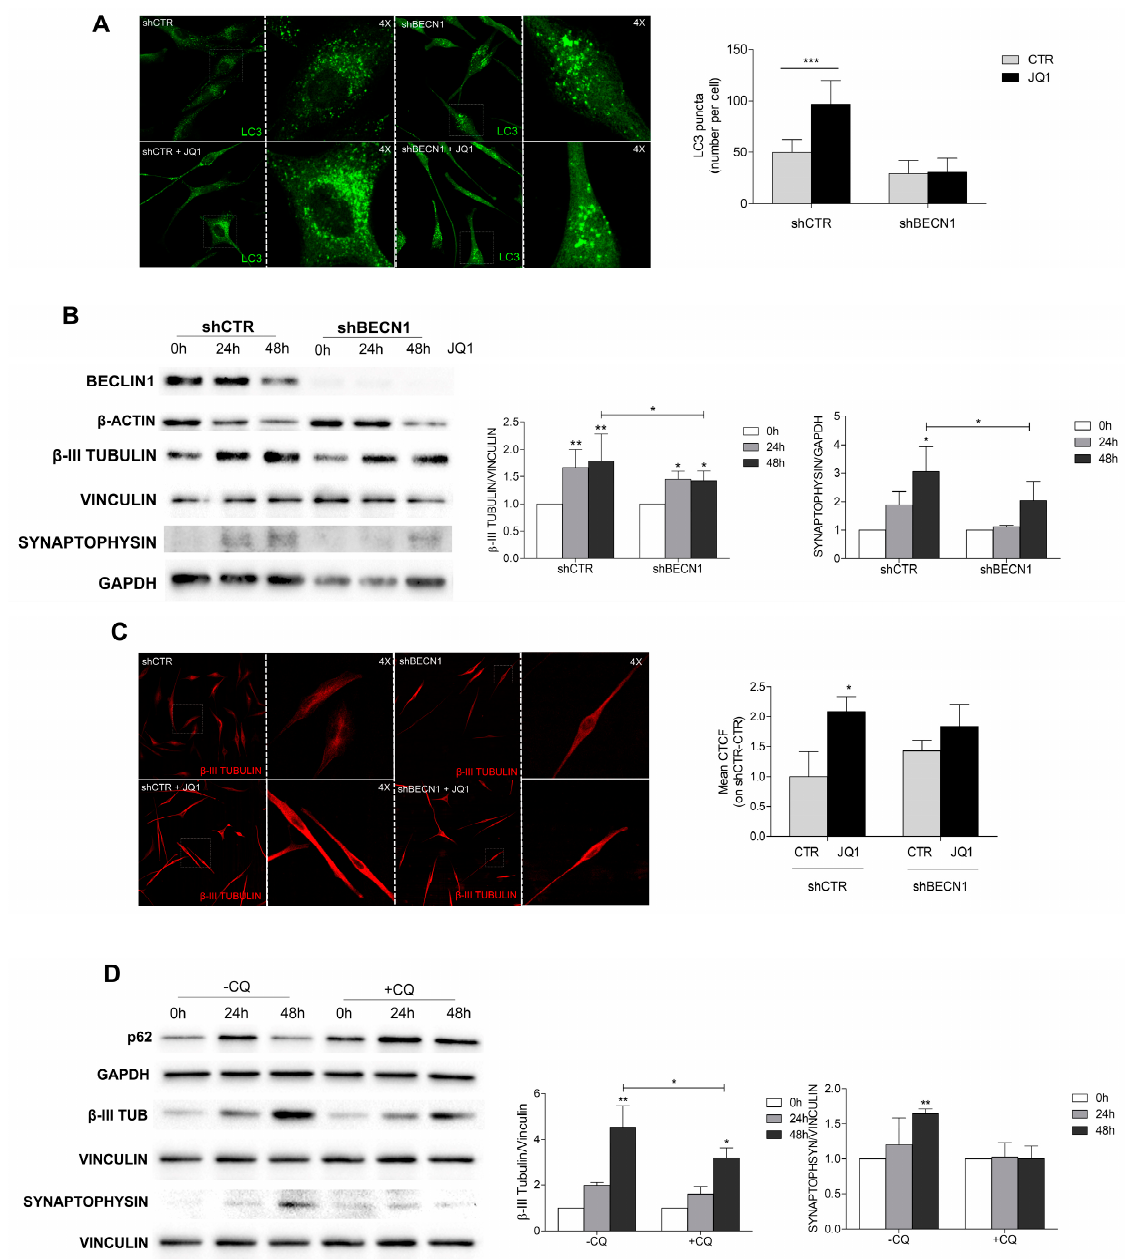
Figure 6. Autophagy-defective cells are less likely to differentiate than autophagy-proficient ones. (A) GL15 cells silenced for the BECN1 gene (shBECN1) or for a scramble gene (shCTR) were cultured in DMEM (CTR) or in the presence of 0.5 µ M of JQ1 for 48 h and subjected to immunocytochemistry and confocal analysis for LC3 (green). Representative images of at least 10 fields showing the merged signals are shown. Scale bar: 30 µ M. A 4 × magnification is shown in the right panel. The LC3 puncta per cell were counted in 30 cells for each condition and the corresponding graph is shown. Statistical significance: ** p < 0.01 and *** p ≤ 0.001, Student’s t -test. ( B ) Western blot analysis of β 3-TUBULIN and SYNAPTOPHISIN was performed in shBECN1 and shCTR GL15 cells cultured in the presence of 0.5 µ M of JQ1 or in DMEM medium (CTR) for 24 and 48 h. A specific antibody for BECLIN1 was used to confirm the silencing efficiency. GAPDH, VINCULIN, and β -ACTIN were used as loading controls. Each blot is representative of three independent experiments. The corresponding densitometric analyses are shown in the graphs. Statistical significance: * p < 0.05, ** p < 0.01 and *** p ≤ 0.001, two-way ANOVA. ( C ) Immunocytochemistry and confocal analysis for β 3-TUBULIN expression (red) was performed in shCTR and shBECN1 cells grown alone (CTR) or in the presence of 0.5 µ M of JQ1. Scale bar: 30 µM. A 4× magni fi cation is shown in the right panel. Analysis of the mean corrected total cell fl uorescence (CTCF) was performed by Image J software on 10 fi elds per each condition, and the corresponding graph is shown. Statistical signi fi cance: *** p ≤ 0.001, Student t-test. ( D ) GH2 cells were stimulated with of 0.5 M of JQ1 for 24 and 48 h, and 20 M of chloroquine (CQ) was added in the last 16 h. Western blo tt ing analysis was performed on the protein extracts and the expression of 3-TUBULIN and SYNAPTOPHISIN was analyzed. The